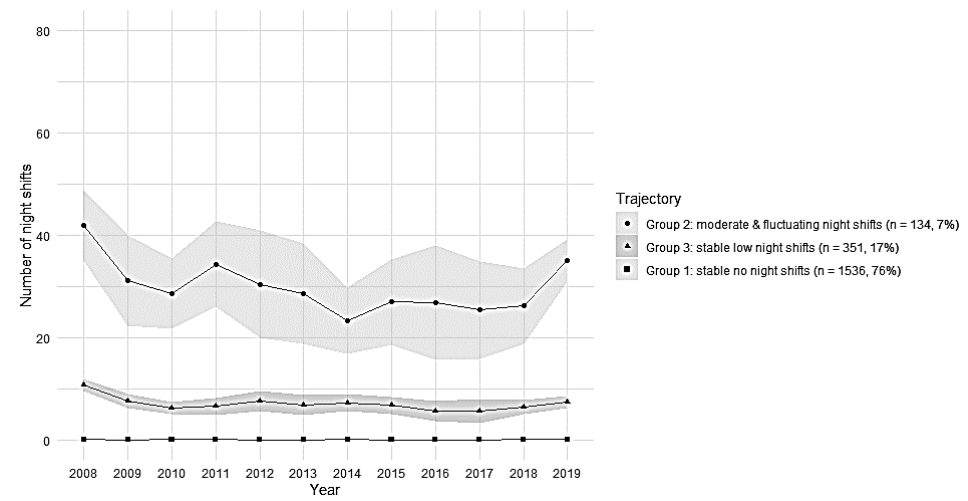
Figure 4. Trajectories of mean annual number of night shifts with 95% CI in sample 3 ( n = 2021